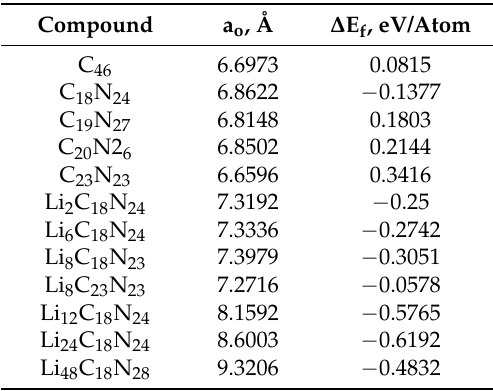
Figure 7. Comparisons of computed energy curves and energy of formation for Type I C 46 , N y C 46-y , and A x N y C 46-y with various amounts of Li guest atoms as a function of lattice parameter: ( a ) energy change curve and ( b ) energy of formation. From Chan et al. [20]. Table 2. Summary of the computed lattice constant a o and energy of formation Δ E f for Type I carbon clathrate compounds. From Chan et al. [20].